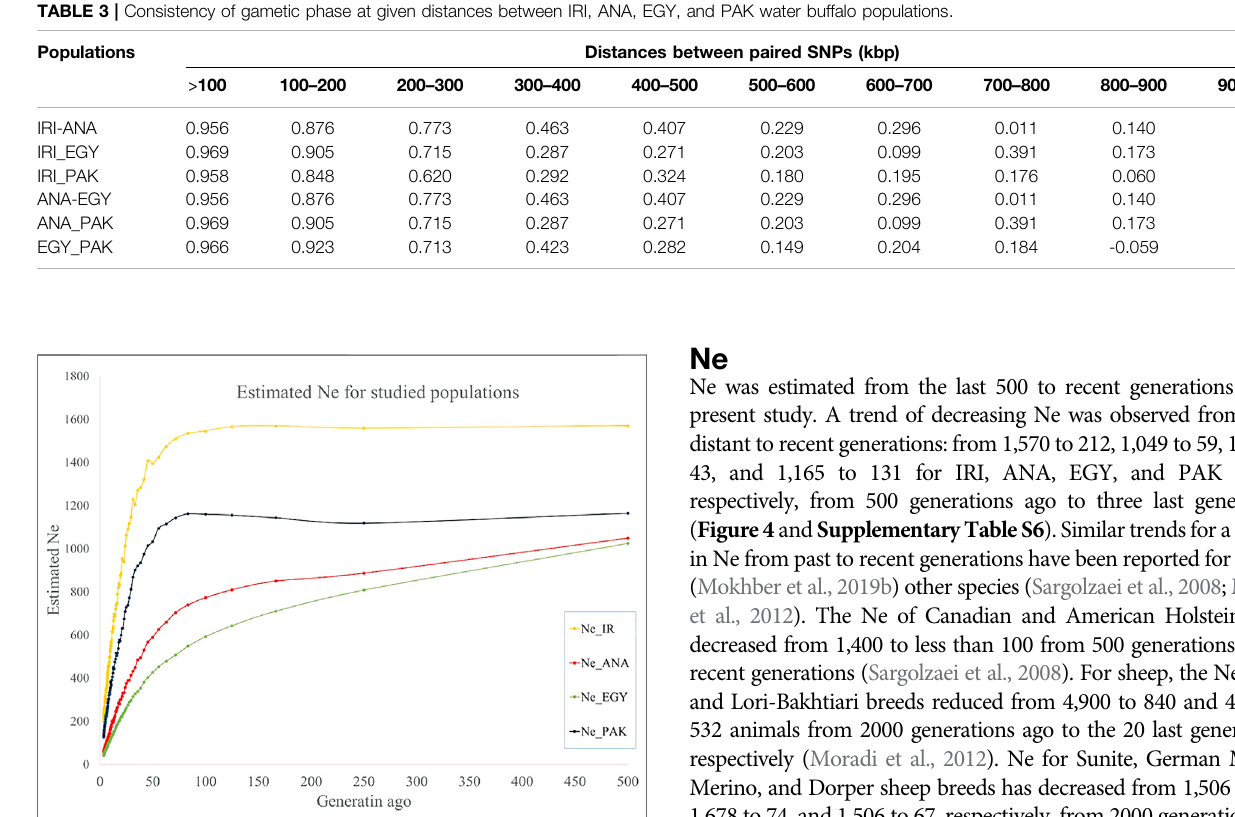
FIGURE 4 | Estimated Ne for IRI (pooled Iranian breeds including AZI, KHU,andMAZ),ANA,EGY,andPAK(pooledPakistanibreeds includingKHU and NIL) water buffalo populations for past